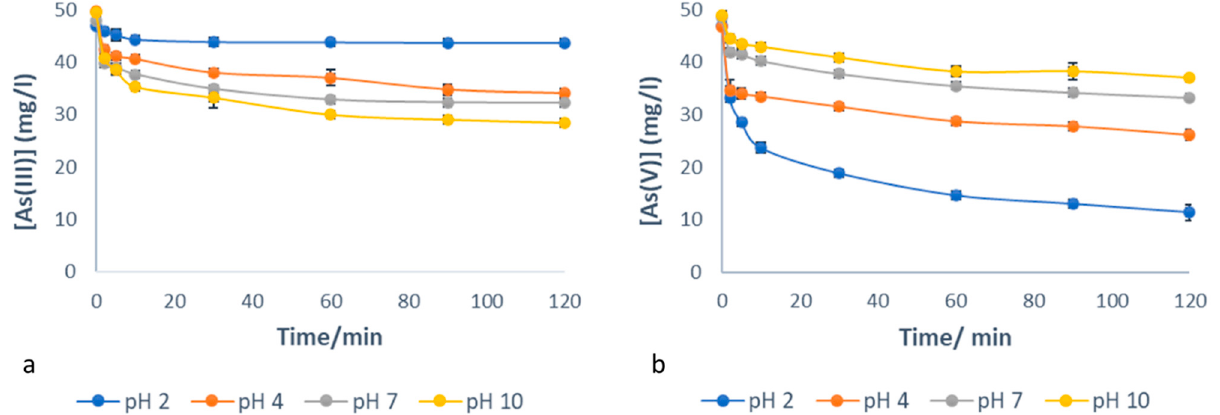
Figure 2. Effect of pH value on arsenic adsorption by biogenic iron precipitates (1 g/L of adsorbent) from ( a ) arsenite solutions (C 0 (As(III)) = 50 mg/L) and ( b ) arsenate solutions (C 0 (As(V)) = 50 mg/L).